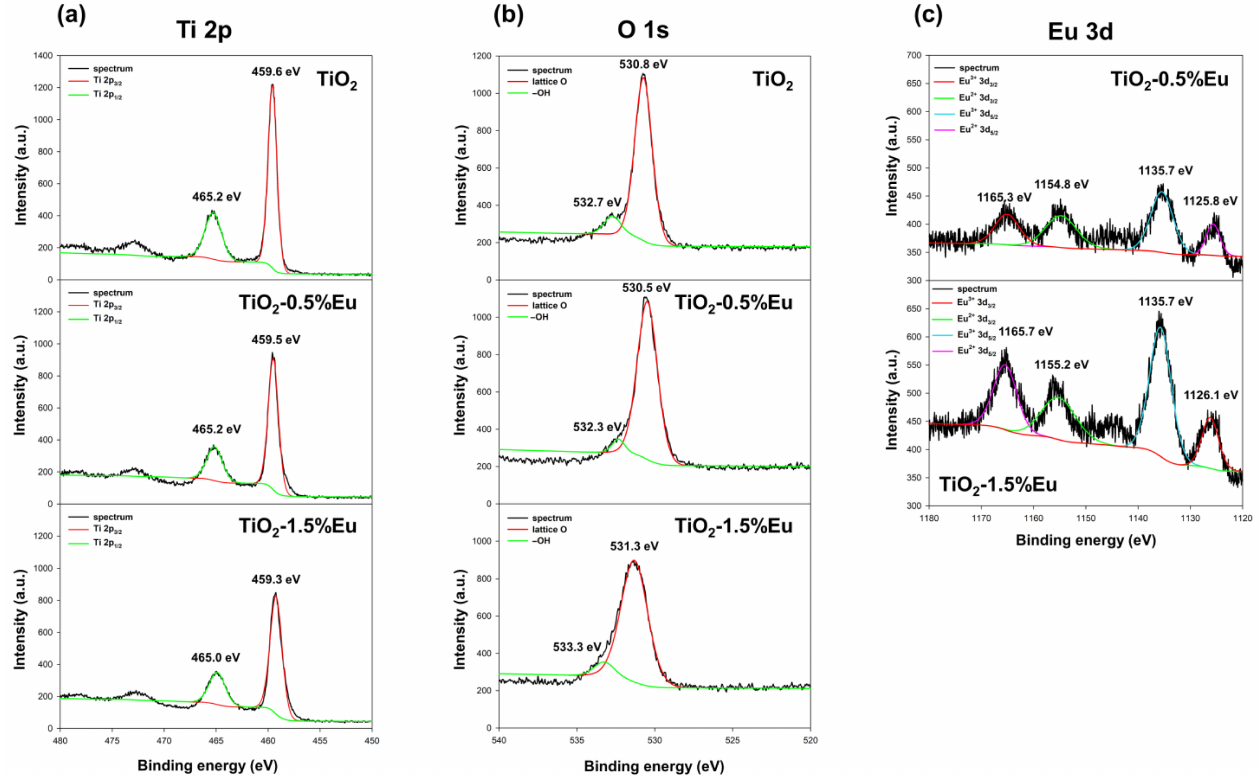
Figure 4. XPS spectra of specific regions: ( a ) Ti 2p, ( b ) O 1s, and ( c ) Eu 3d for TiO 2 -Eu